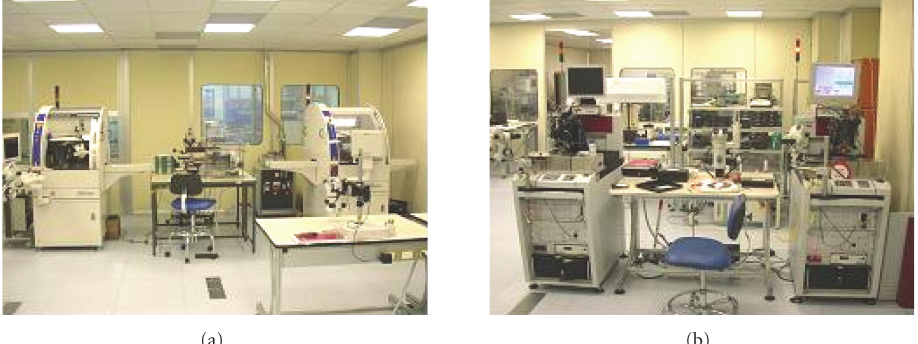
Figure 11: TR module production lines: two in parallel lines were developed to meet the required production rate up to 300 TR